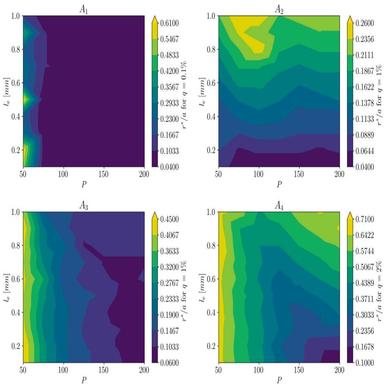
Convergence distance from the crack tip for 1 ,… , 4 depending on different e and .